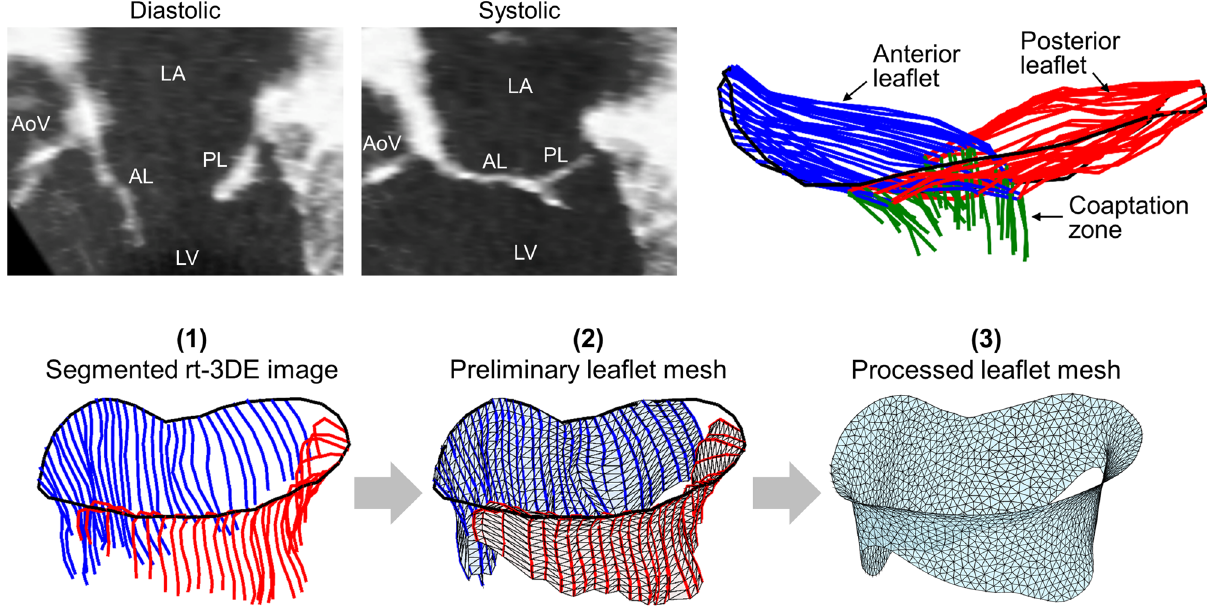
Figure 11. Pipeline for MV geometric modelling, starting from noninvasive rt-3DE images of the valve. Cross sections of each image are first interactively traced, and then the segmented geometry is converted to a subject- specific triangulated mesh suitable for FE simulations (adapted from Rego et al. 20 ). AL, anterior leaflet; PL, posterior leaflet; LA, left atrium; LV, left ventricle; AoV, aortic